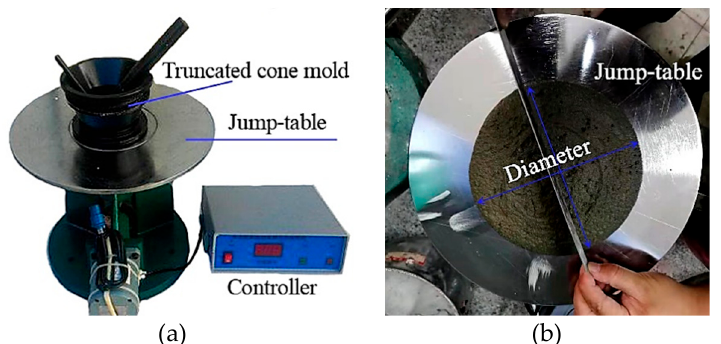
Figure 1. The testing method to the fluidity of SR–FFA based geopolymer mortar: ( a ) Testing device of cement mortar and ( b ) measurement of result.